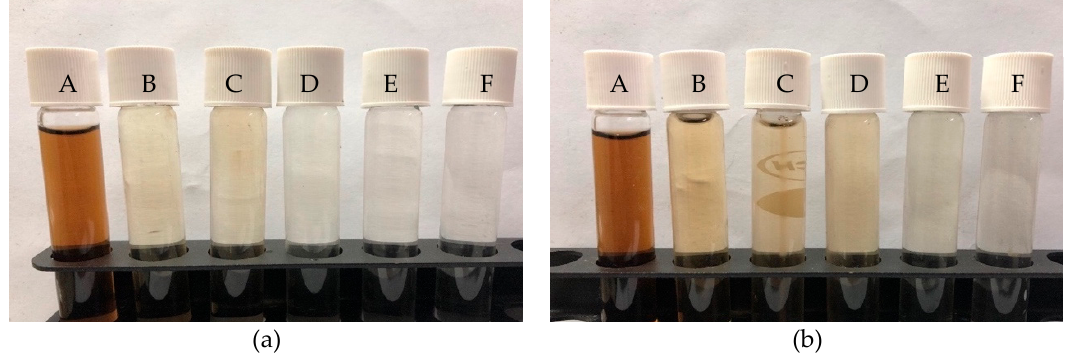
Figure 8. Pictorial view of color removal at 5 h contact time: ( a ) microwave irradiated and ( b ) H 2 SO 4 –microwave irradiated at varied adsorbent dosages in 200 mL (A = control, B = 3 g, C = 6 g, D = 9 g, E = 12 g, F = 15 g).